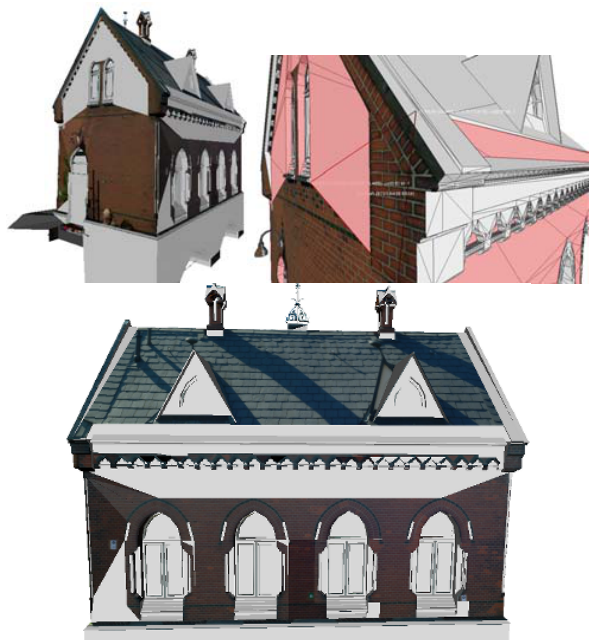
Figure 17. Result of automatic texture mapping of the 3D CAD model of the Fleetschlösschen in Hamburg-HafenCity – Problem: triangles without